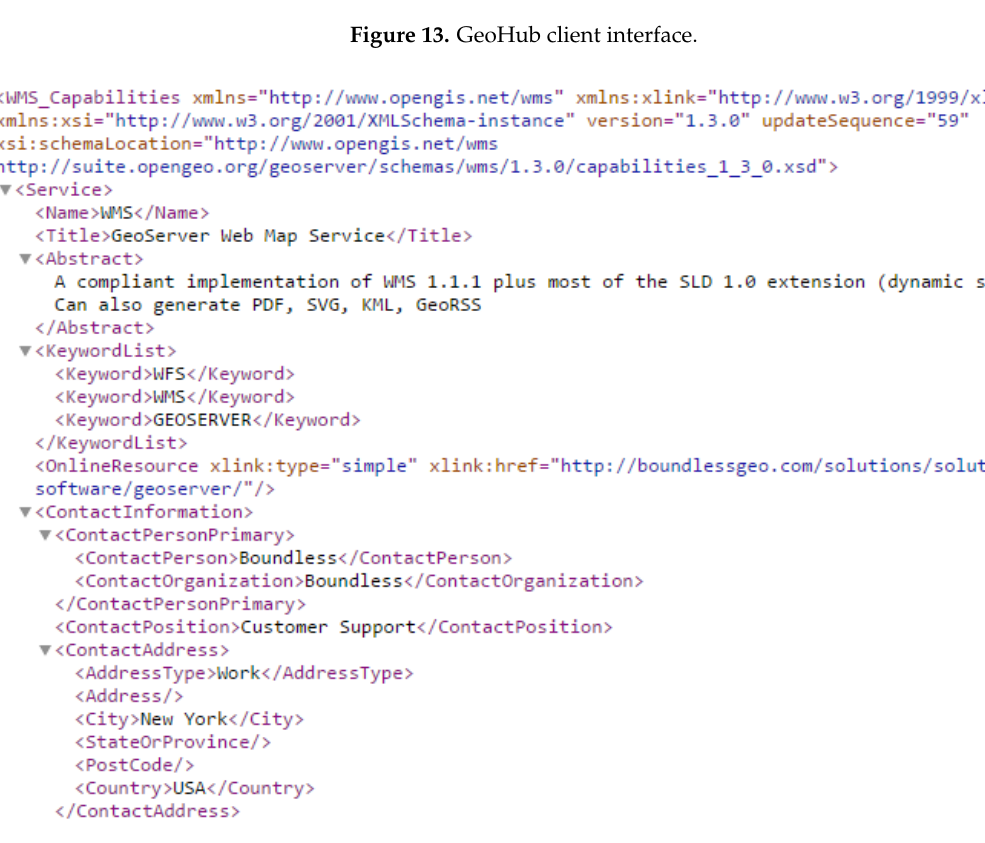
Figure 14. An example of a WMS capabilities document.